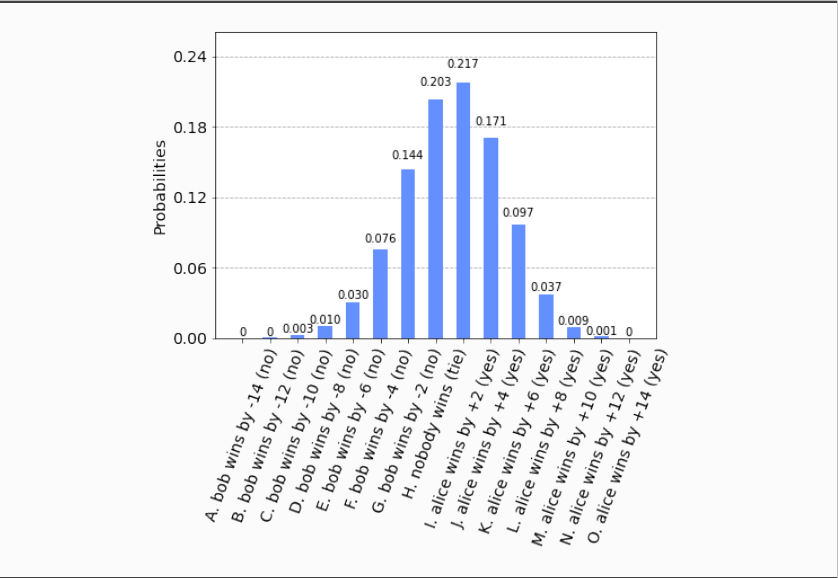
Figure 18. The possible outcomes and their probabilities with 2 independent legislators and r A = r B =